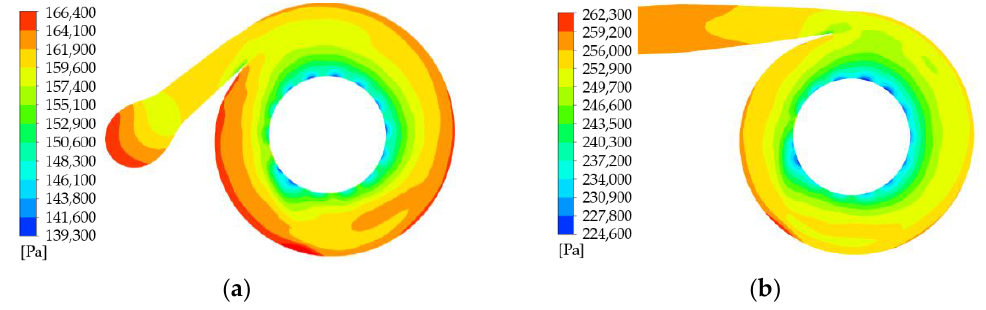
Figure 11. Static pressure contours of diffusers and volutes. ( a ) First stage. ( b ) Second stage.